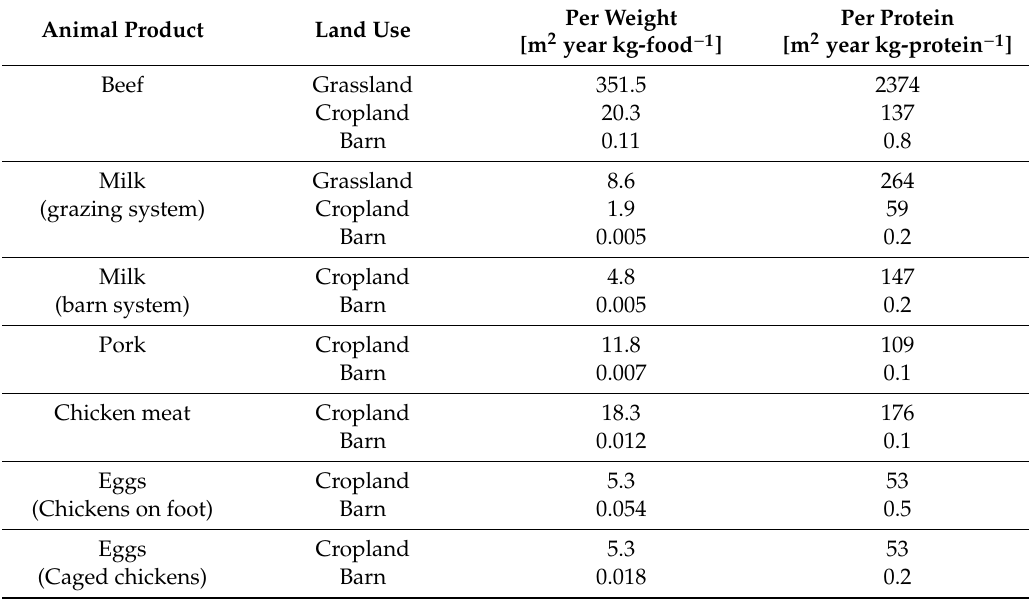
Table 9. Contributions of three types of land use to the Land Requirement for Animal Production (LRAP) in Mexico, and to the protein content of the animal products. Animal